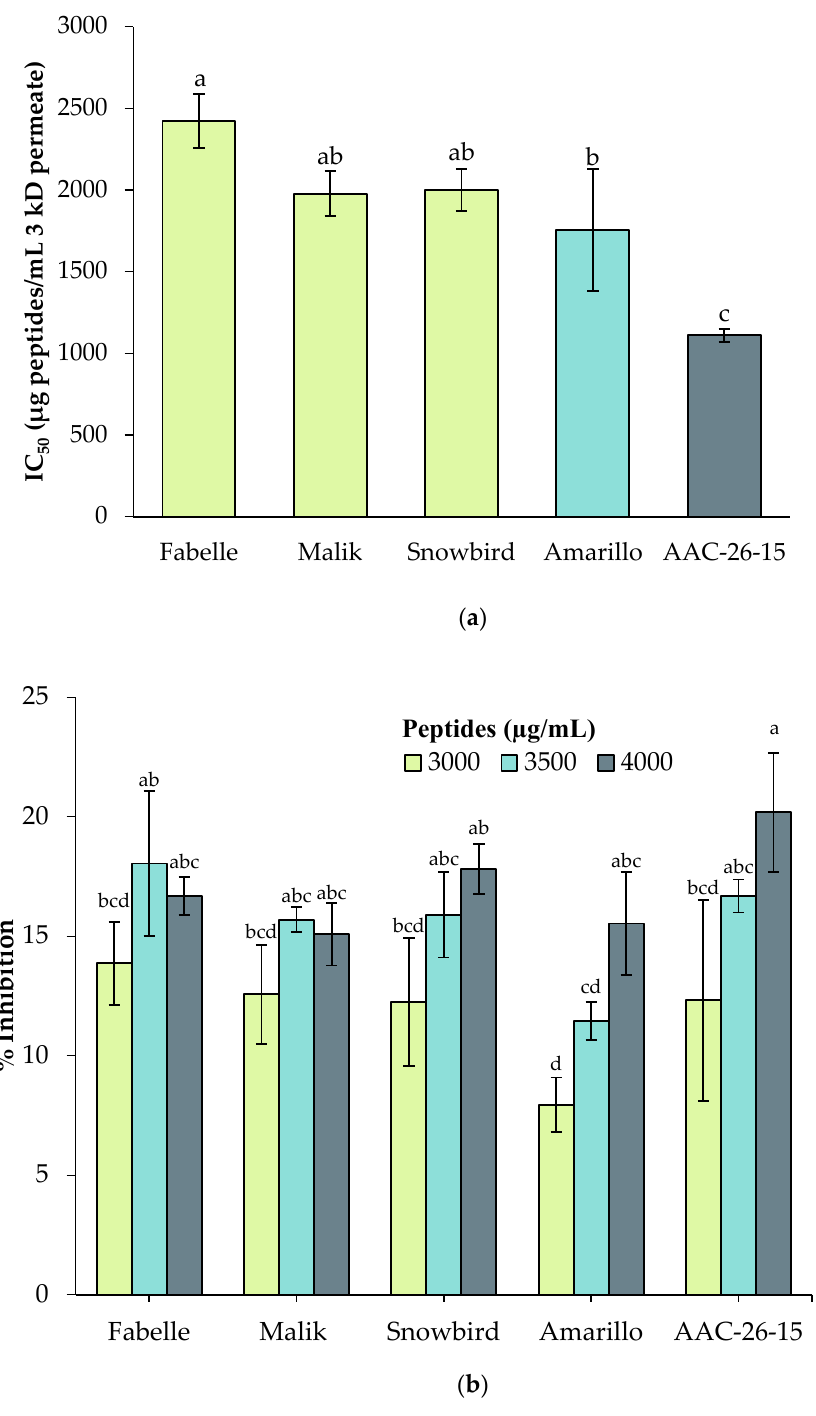
Figure 8. Antidiabetic activity (Dipeptidyl ‐ Peptidase ‐ IV inhibition) of the 3 kDa permeate of legume digestates: ( a ) in vitro assay with a purified Dipeptidyl ‐ Peptidase ‐ IV from porcine kidney; ( b ) inhibition assay in a cellular model. Data are expressed as mean ± standard deviation and means without a common letter differ ( p < 0.05) as analyzed by one ‐ way ANOVA and the Tukey’s test.